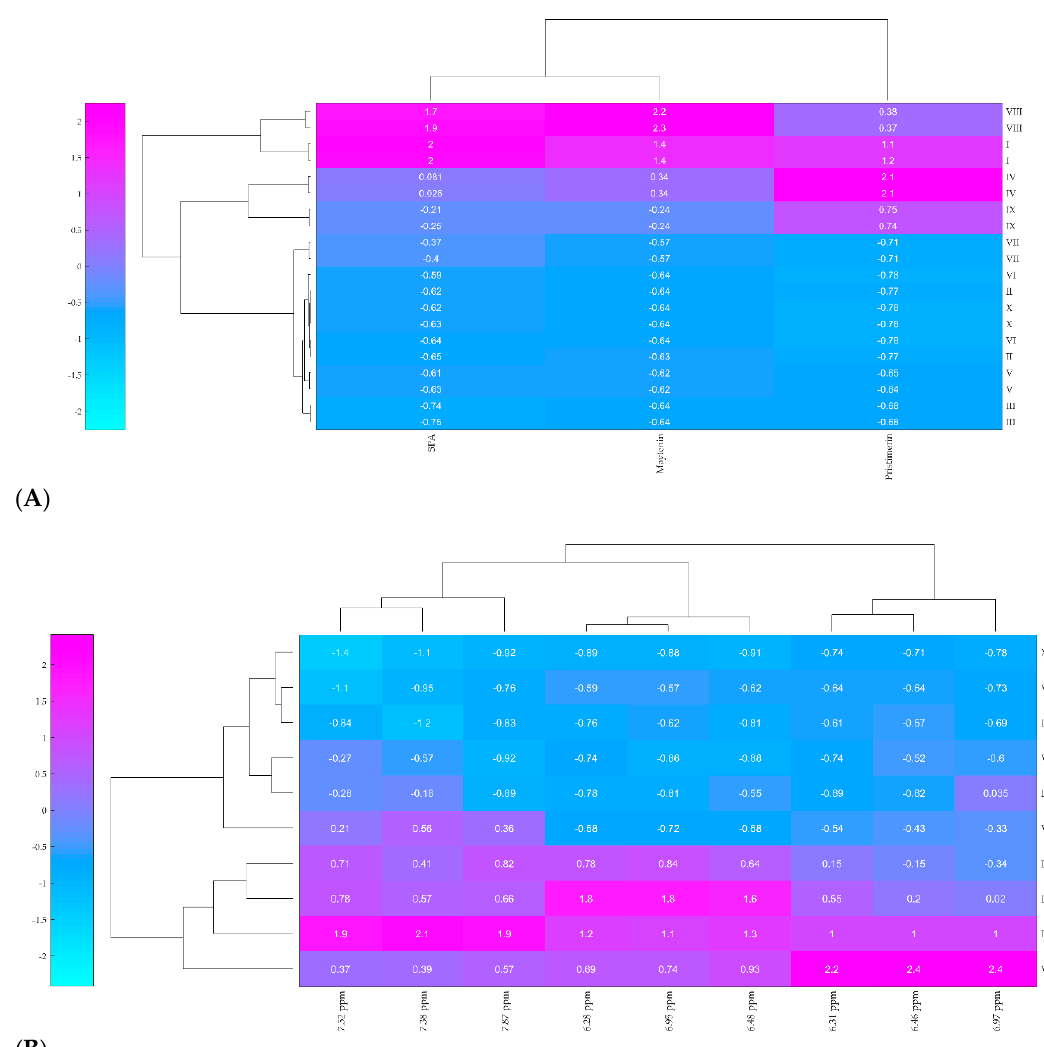
Figure 4. HCA of chemical data. Samples with similar color (hence, similar Euclidian distances) are clustered together. ( A ) Clustergram from HPLC-DAD data. Input was the total integrated areas of SPA, pristimerin and maytenin peaks displayed in each chromatogram. ( B ) Clustergram from 1 H-NMR data. Input was the total integrated areas of SPA, pristimerin and maytenin aromatic signals displayed in each spectrum: SPA aquifoliunin E1 signals [ δ 7.87 ( dd , J 8.0 and 1.0 Hz, 2H, ortho ), δ 7.52 ( t , J 8.0 Hz, 1H, para ) and δ 7.38 ( dd , J 7.4 and 8.2 Hz, 2H, meta )]; pristimerin signals [ δ 6.95 ( dd , J 7.1 and 0.8 Hz, 1H, H-6), δ 6.48 ( d , J 0.8 Hz, 1H, H-1) and δ 6.31 ( d , J 7.1 Hz, 1H, H-7)] and maytenin signals [ δ 6.97 ( dd , J 7.2 and 0.8 Hz, 1H, H-6), δ 6.46 ( d , J 0.8 Hz, 1H, H-1)] and δ 6.28 ( d , J 7.2 Hz, 1H, H-7).